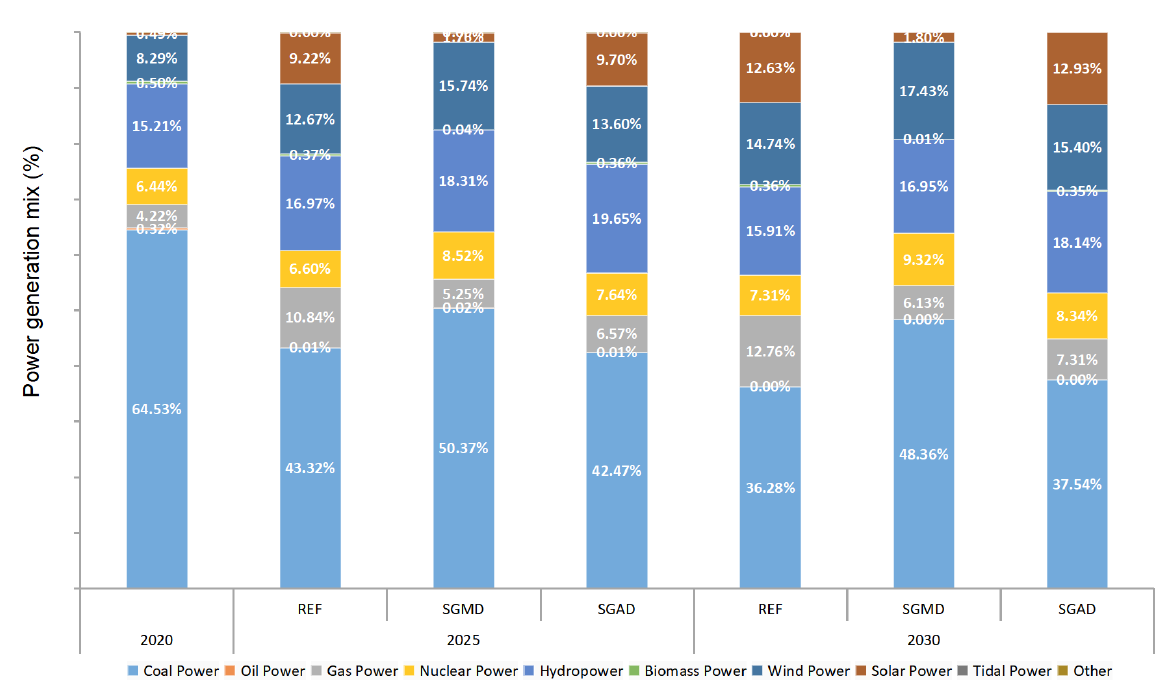
Figure 9. Power generation